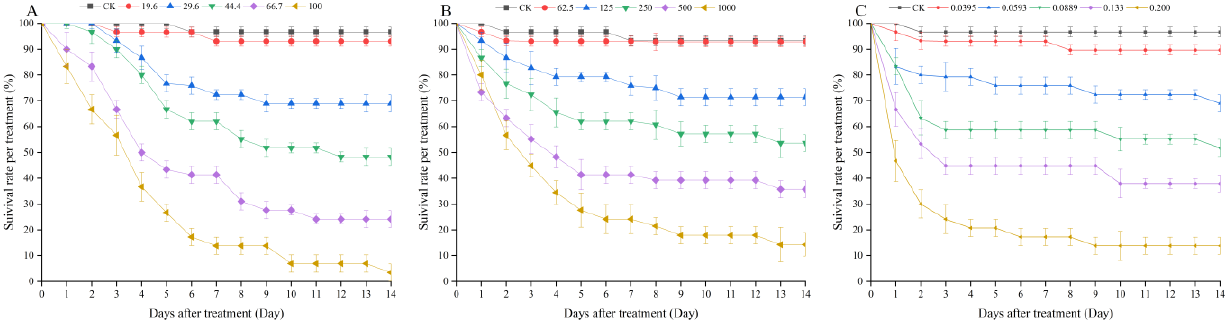
Figure 1. Effects of three diamide insecticides on the survival rate of C. septempunctata larvae during the 14 d observation period before pupation ( A ) chlorantraniliprole 10% SC; ( B ) tetrachlorantraniliprole 10% SC; ( C ) broflanilide 10% SC). Data are represented as mean ± SE (ANOVA, Tukey’s LSD, p < 0.05). Table 3. Calculation of HQs of three diamide insecticides of C. septempunctata .